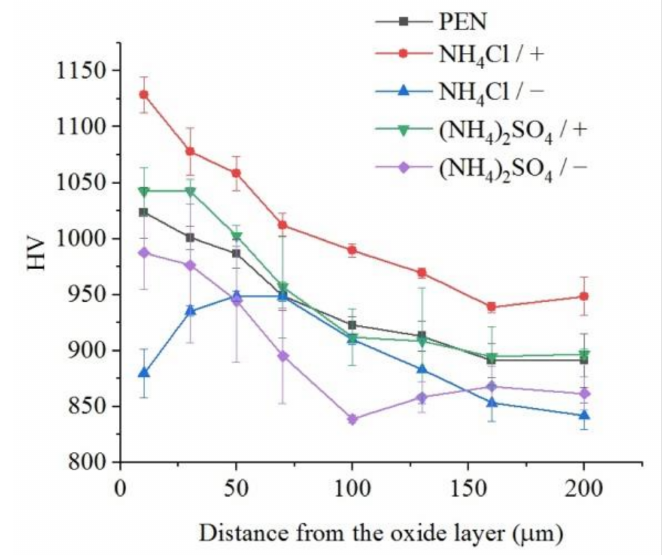
Figure 13. Distribution of microhardness in the surface layer of steel after PEN and subsequent PEP at a voltage of 300 V in ammonium sulfate (3%) or ammonium chloride (3%) solutions at a temperature of 80 ◦ C under forced circulation (+) or natural convection ( − ) of electrolyte.